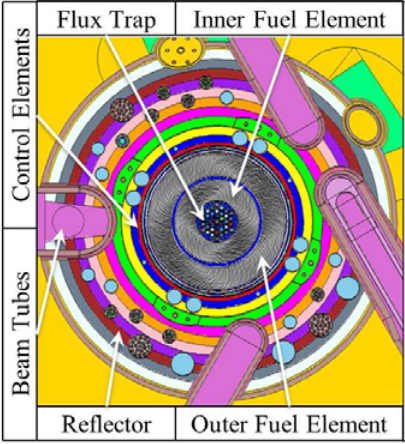
Figure 1. HFIR core mockup. Figure 2. HFIR neutronics